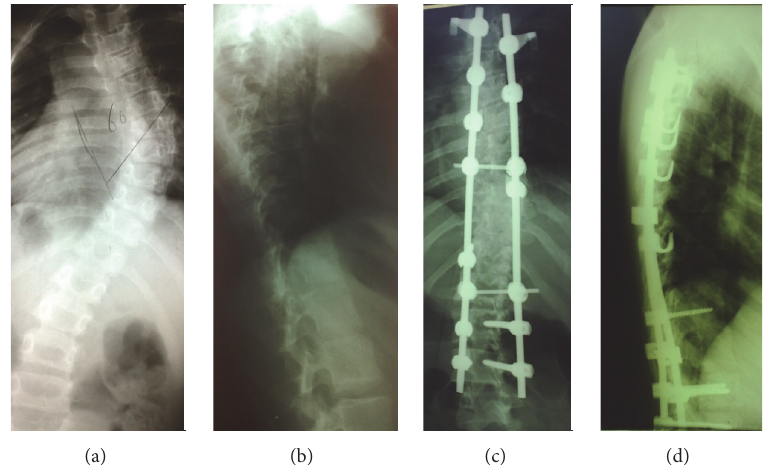
Figure 1: (a) and (b) A 17-year-old girl with AIS, with 2-year brace treatment. (c) and (d) After correction, PSF and instrumentation by hybrid thoracic hook lumbar screw technique.